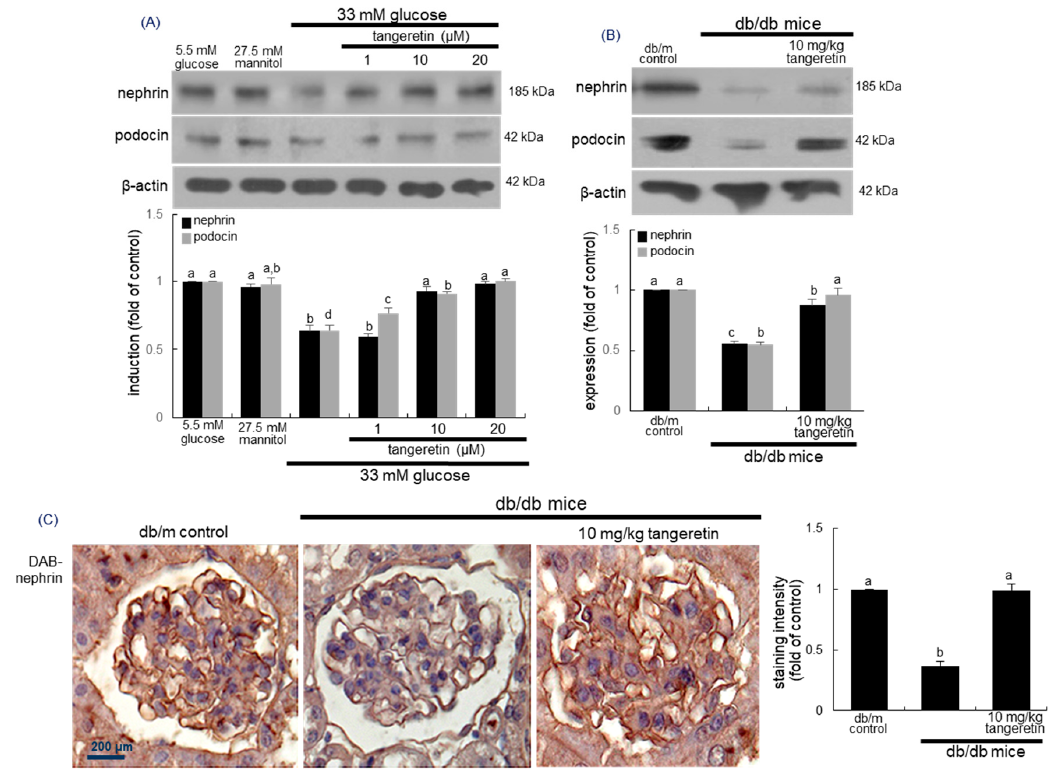
Figure 3. Elevation of induction of nephrin and podocin by tangeretin in podocytes and diabetic kidneys. Podocytes were incubated with 33 mM glucose in the presence of 1–20 μ M tangeretin for 4 days ( A ). The db/db mice were orally supplemented with 10 mg/kg tangeretin for 10 weeks ( B , C ). Cell lysates and tissue extracts were electrophoresed on 8%–12% SDS-PAGE and subject to Western blot analysis with a primary antibody against nephrin and podocin ( A , B ). β -Actin antibody was used as an internal control. The bar graphs (mean ± SEM, n = 3) in the bottom panels represent quantitative results of upper blot bands obtained from a densitometer. Respective values not sharing a letter are different at p < 0.05. Immunohistochemical staining showing glomerular tissue level of nephrin of diabetic mouse kidney ( C ). The glomerular nephrin was confirmed with 3,3 ′ -diaminobenzidine (DAB), producing a brown staining, counterstained with hematoxylin and was quantified. Each photograph is representative of four mice. Scale bar = 200 μ m.